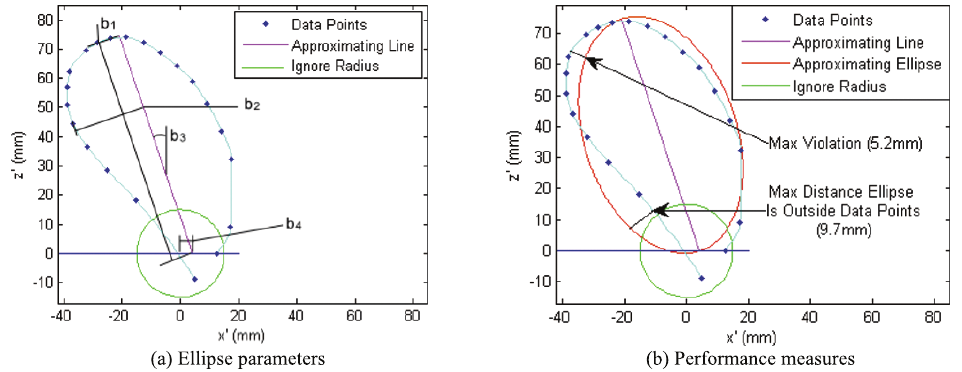
Fig. 14. Parameters for an ellipse to bound the path are derived from a line fit to the path, ignoring the path within a radius of the final location. The performance of the ellipse is by error (not bounding the path) and conservativeness (excessive distance from the path). The ellipse shape does a good job of bounding the path with a few intuitive